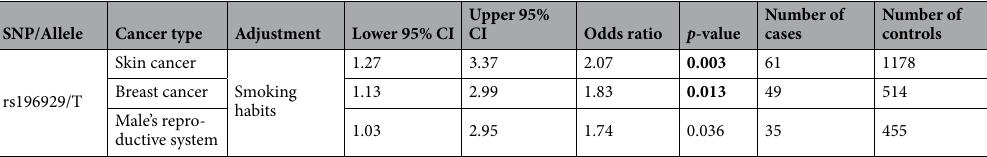
Table 3. Conditional logistic regression analysis of associations between the rs196929 and different types of cancer in patients with tooth loss ( p -values below 0.05). Bold indicates statistically significant